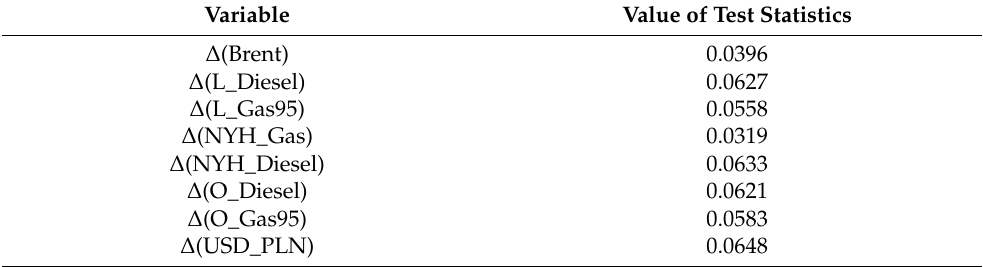
Table 4. KPSS test